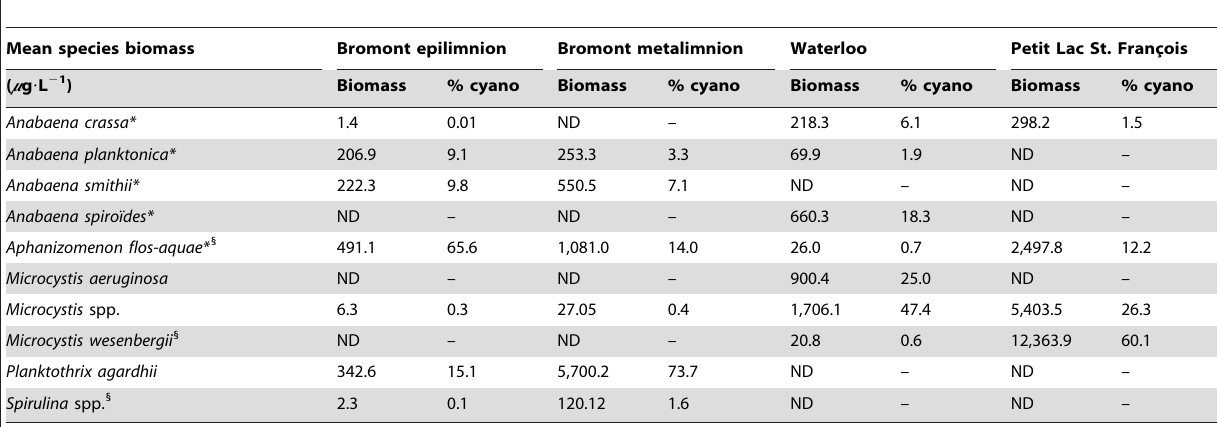
Table 2. Average biomass ( m g ? L 2 1 ) and mean percent of total cyanobacterial biomass (% cyano) of the dominant cyanobacterial taxa observed in the three study lakes across all sampling dates.